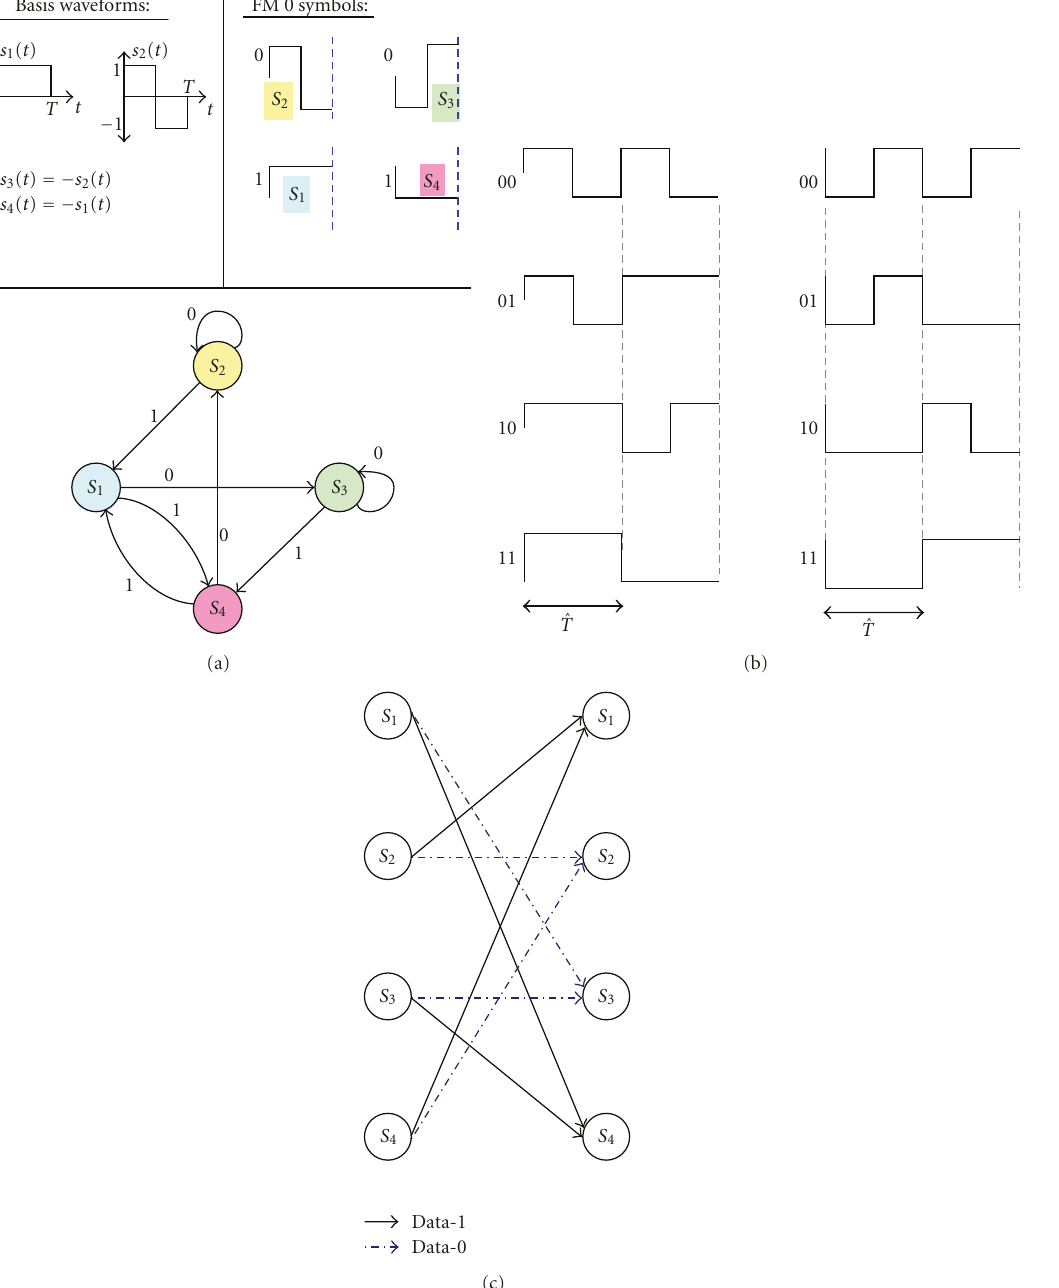
with phase inversion at symbol boundary, the FM0 baseband scheme can be equivalently represented as a hidden Markov information source, as illustrated by the state diagram of the Moore machine in Figure 2(a) . This state diagram defines four states, { S 1 , ... , S 4 } , to represent the corresponding baseband signals { s 1 ( t ), ... , s 4 ( t ) } whereas the directed-links between states denote the transition with the associated